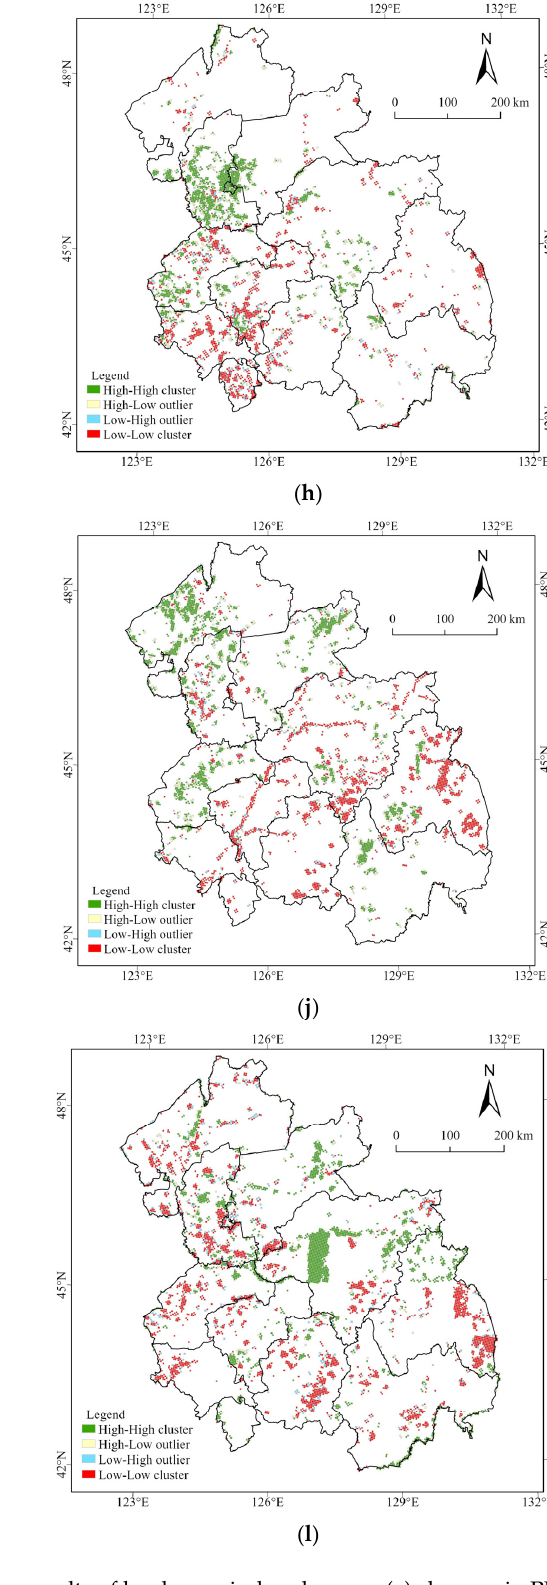
Figure A2. Hotspot identification results of landscape index changes: ( a ) changes in PD from 1990 to 2000; ( b ) changes in PD from 2000 to 2010; ( c ) changes in PD from 2010 to 2020; ( d ) changes in MPS from 1990 to 2000; ( e ) changes in MPS from 2000 to 2010; ( f ) changes in MPS from 2010 to 2020; ( g ) changes in COHESION values from 1990 to 2000; ( h ) changes in COHESION values from 2000